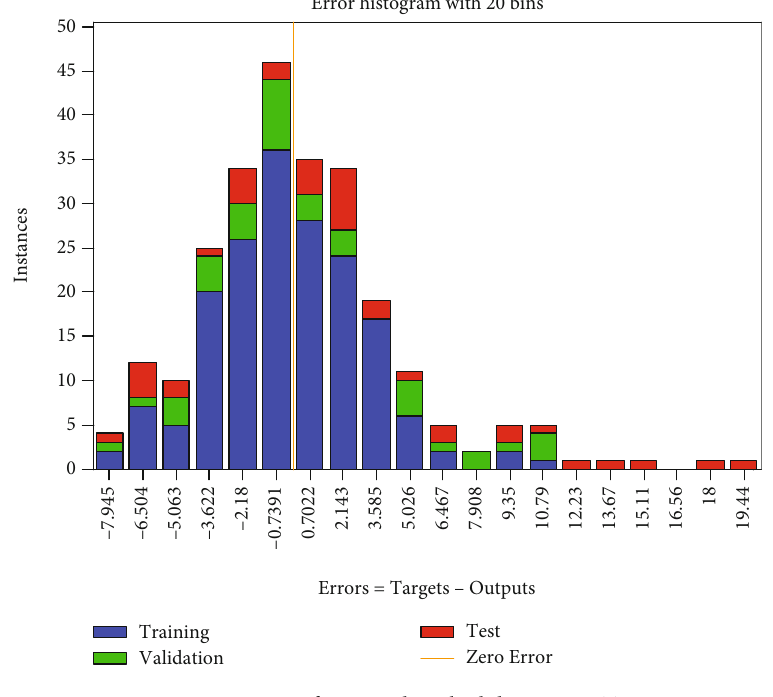
Figure 2: Error of proposed method during MPPT.